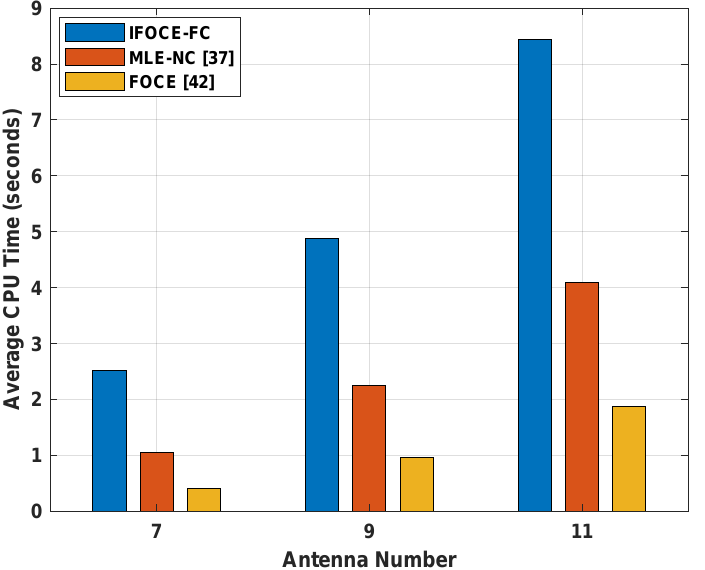
Figure 14. Comparison of different algorithms for the average computation time versus the number of antennas under multiple signals and spatially colored noises in the ULA